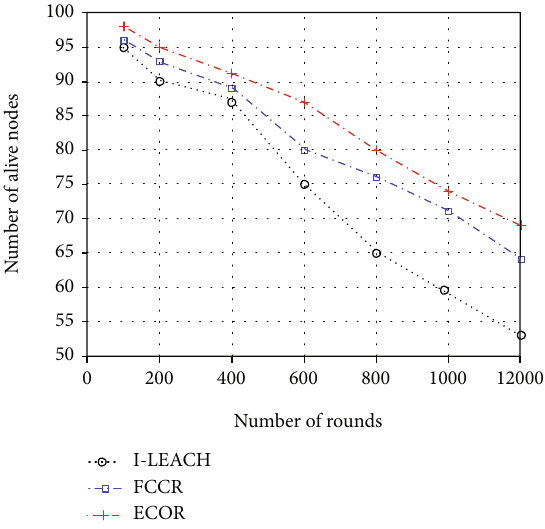
Figure 11: Performance analysis in terms of number of alive nodes.